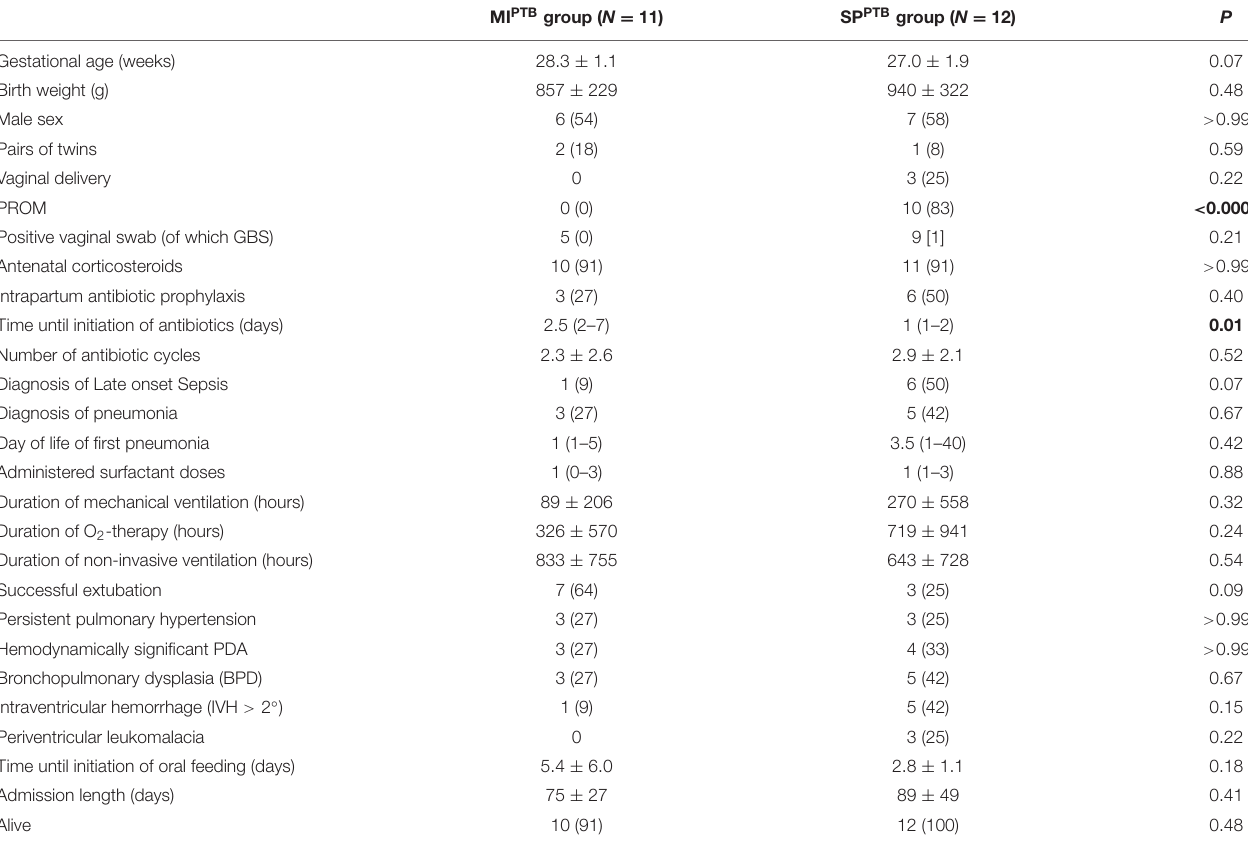
TABLE 1 | Demographic and clinical characteristics of the newborns